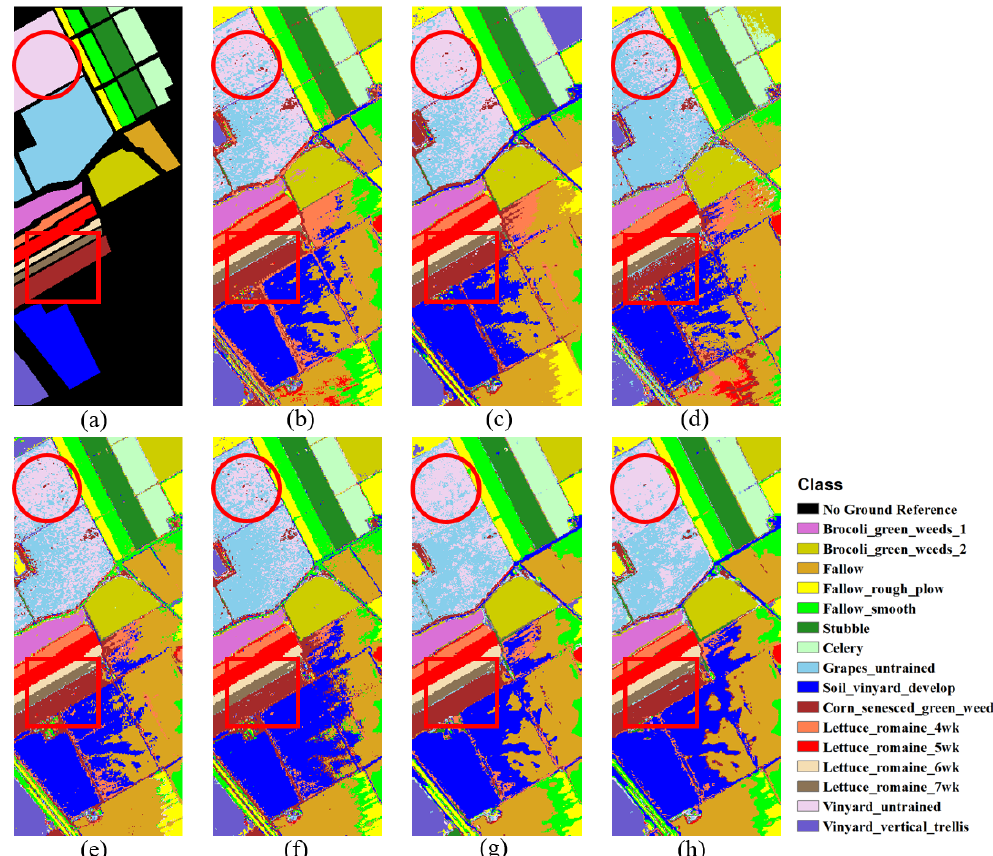
Figure 5. Classification maps of Salinas image from the fifth trial: ( a ) ground-reference map; ( b ) SVM, with OA = 83.38%; ( c ) 1DCNN, with OA = 87.00%; ( d ) 1DLSTM, with OA = 86.85%; ( e ) LSTM_PM_EU, with OA = 86.21%; ( f ) LSTM_PM_SAM, with OA = 87.13%; ( g ) LSTM_BM_EU, with OA = 90.02%; and ( h ) LSTM_BM_SAM, with OA = 90.72%. The red-circle and red-rectangle annotations represent sample areas of interest, discussed in the